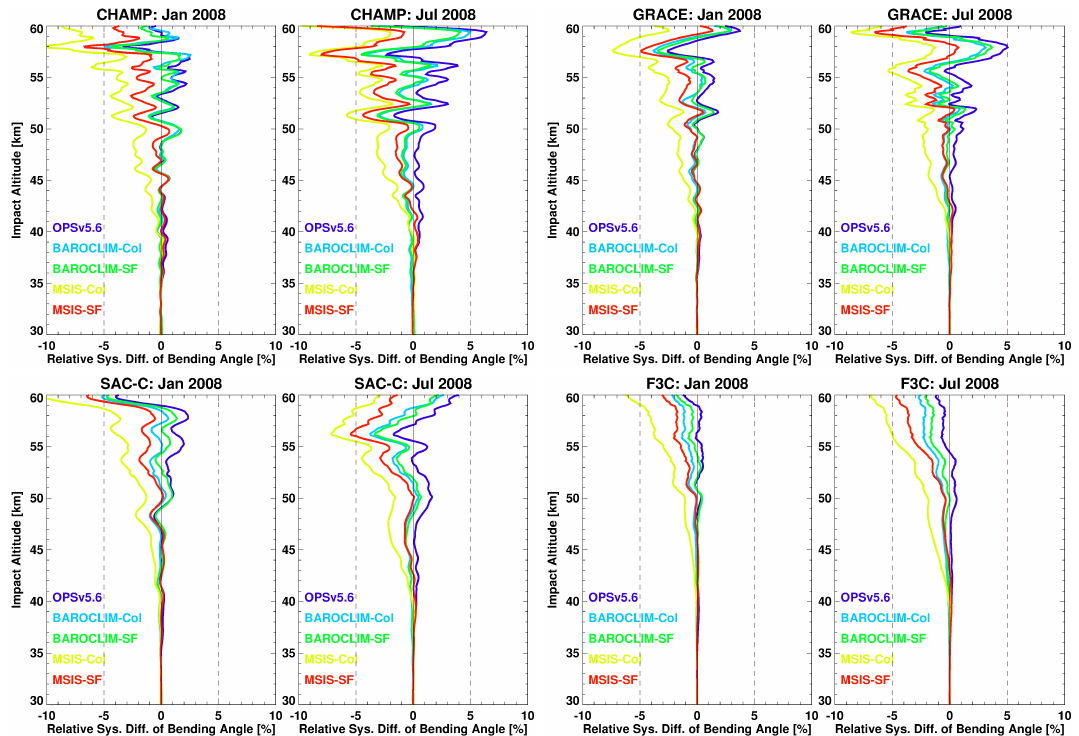
Figure 6. Global statistics of systematic difference between raw and statistically optimized RO bending angles for CHAMP, GRACE-A, SAC-C, and F3C for January 2008 and July 2008. Different colors indicate different a priori information used in the retrieval.